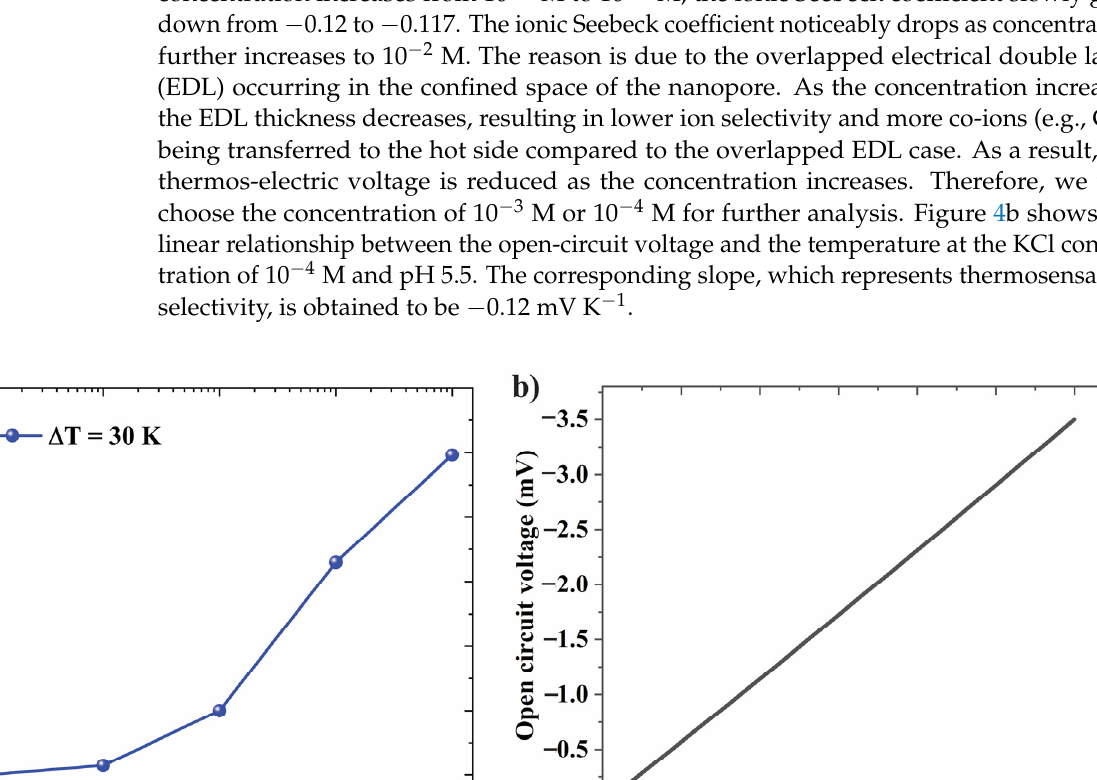
Figure 4. (a) Effect of electrolyte concentration on Seebeck coefficient. ( b ) Linear relation between open-circuit voltage and temperature difference.